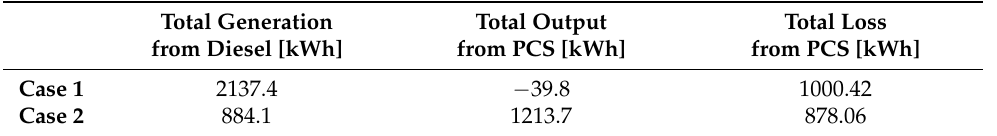
Table 2. Case Study